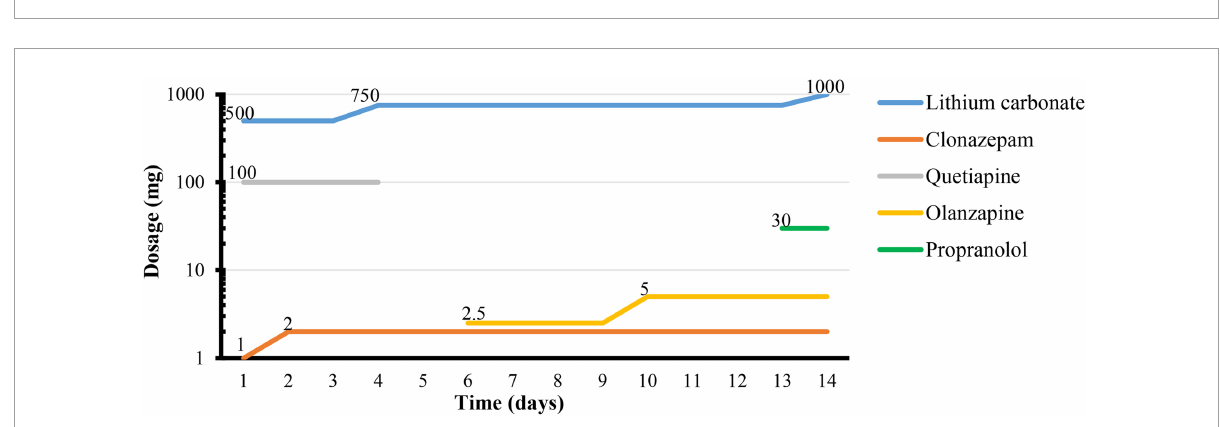
FIGURE1 Symptom-time chart.